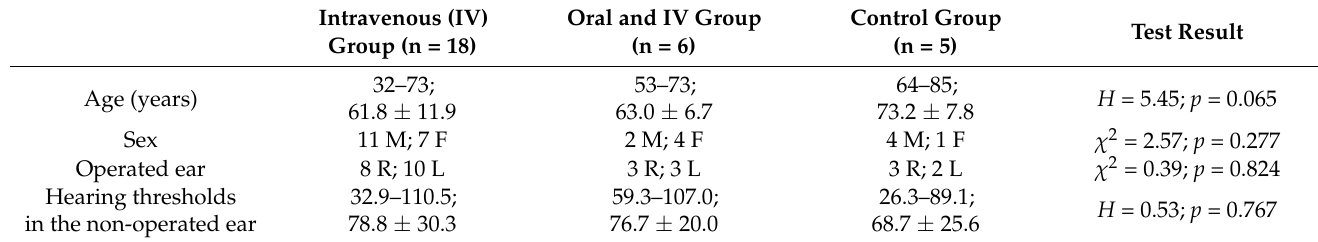
Table 1. Characteristics of patients.